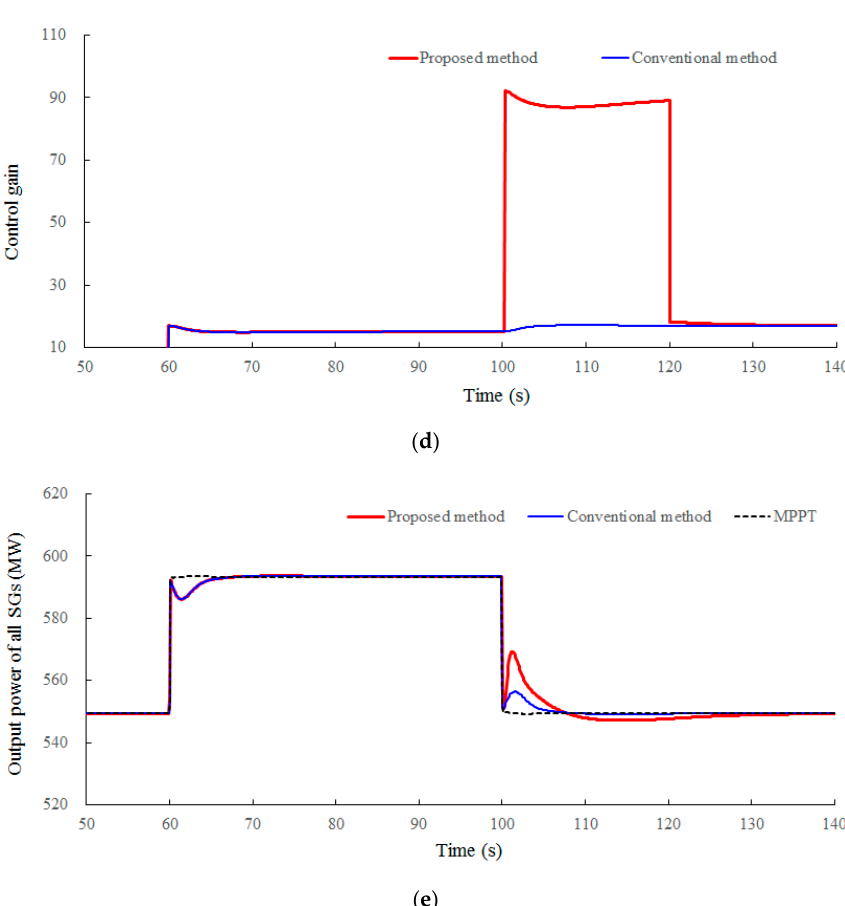
Figure 7. Results for Case 2: ( a ) System frequencies; ( b ) Active powers; ( c ) Rotor speeds; ( d ) Control gain; ( e ) Output power of all synchronous generators.